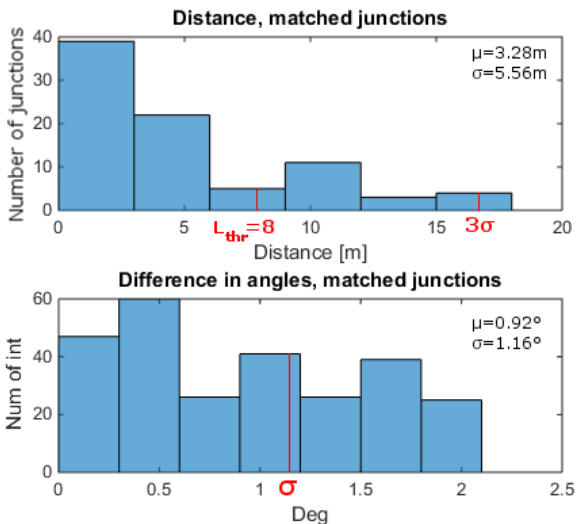
Figure 13: Accepted errors in distance and angular orientation of the matched intersections shown against the number of intersec- tions.